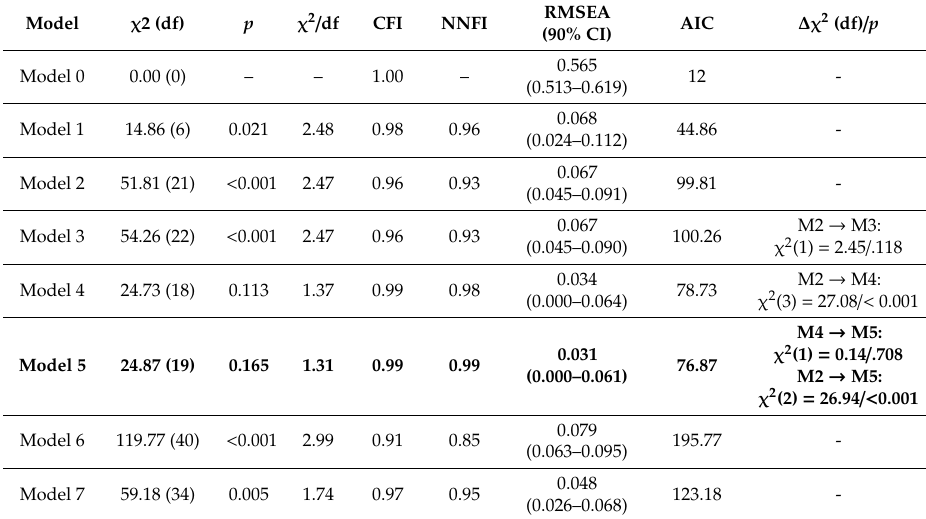
Table 3. General theoretical model—fit indices of path models following a multi-step process to test the longitudinal contribution of each variable on life satisfaction at Time